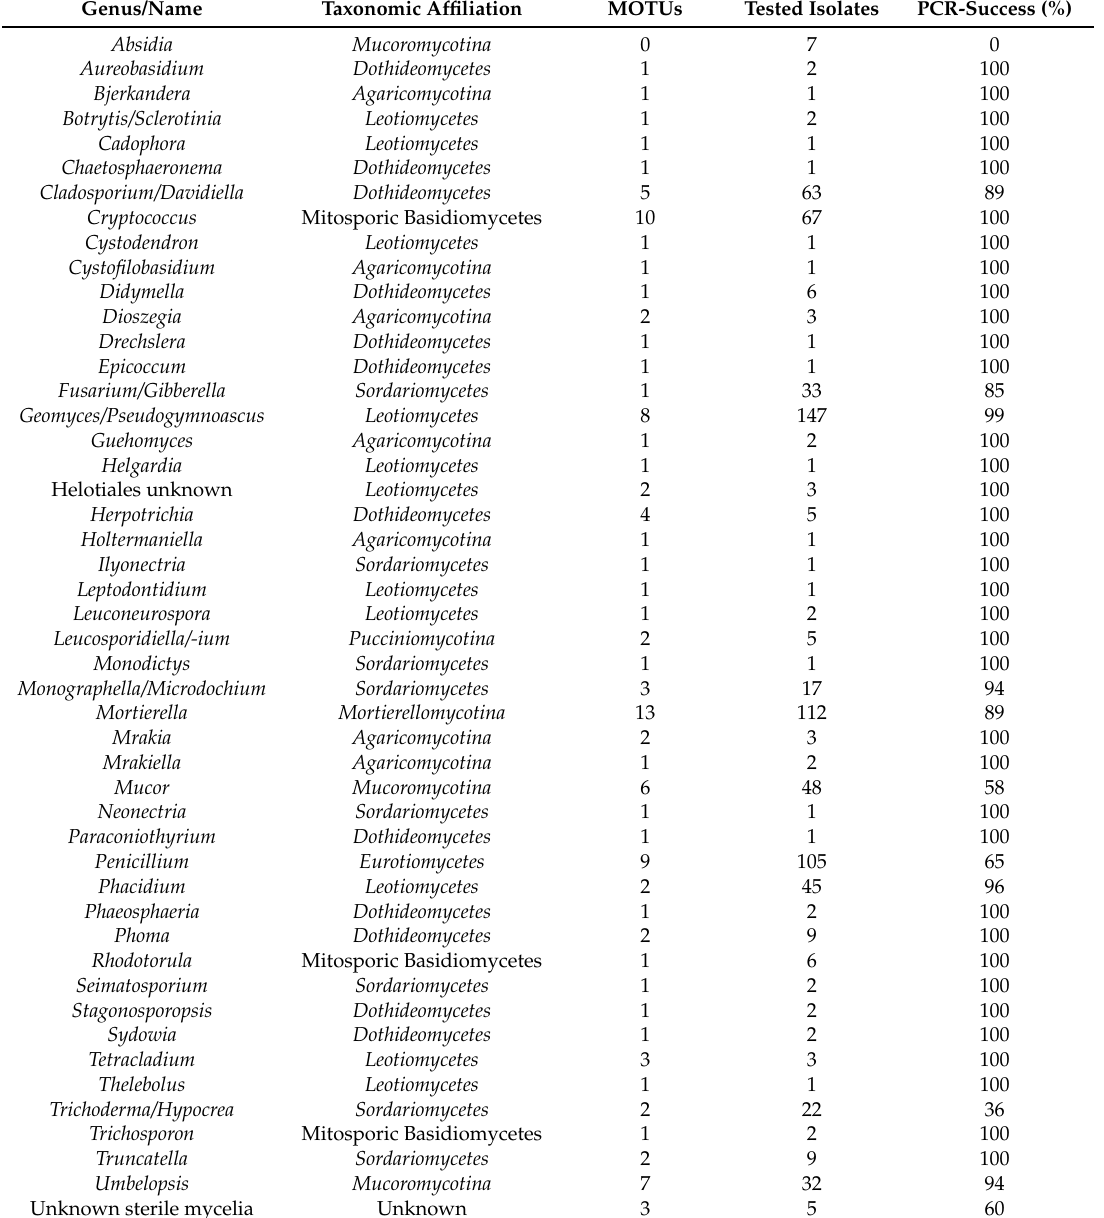
Table 1. Relative direct PCR success for genera of soil fungi (in alphabetical order) with taxonomic affiliations, MOTUs obtained within the genus and number of fungal isolates